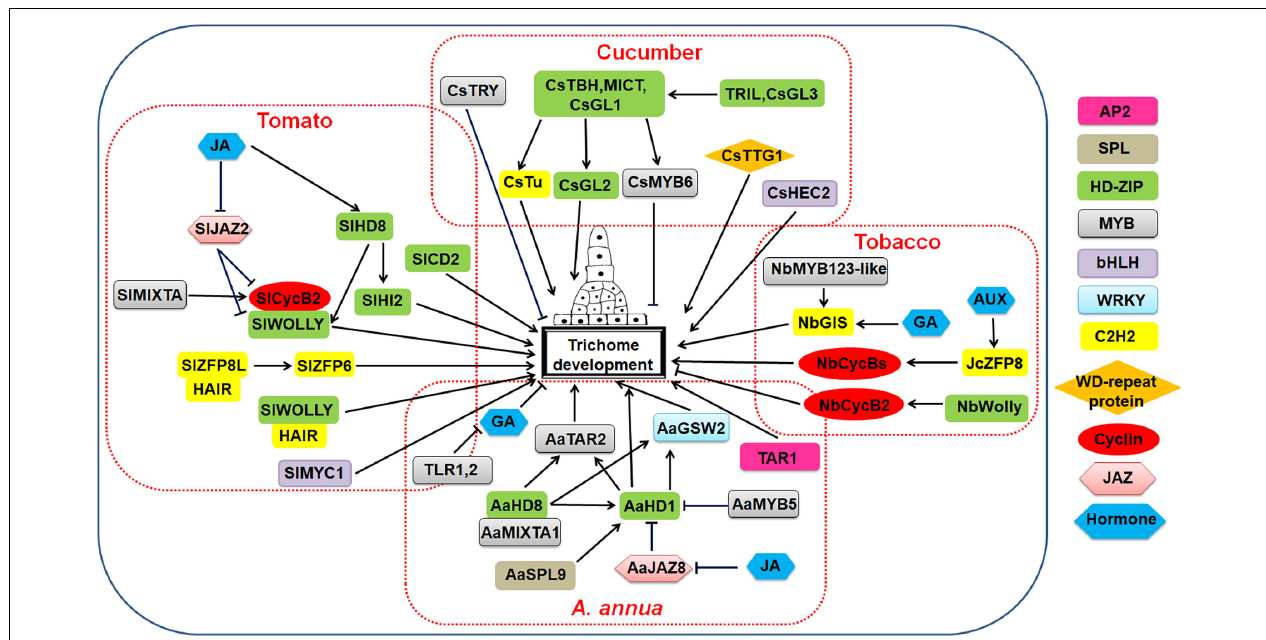
FIGURE 4 | Regulatory network model for multicellular trichome development in cucumber, tomato, tobacco, and Artemisia annua